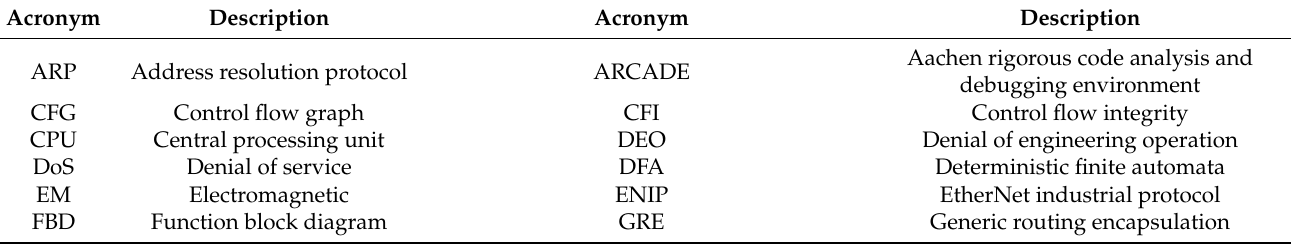
Table A2. List of